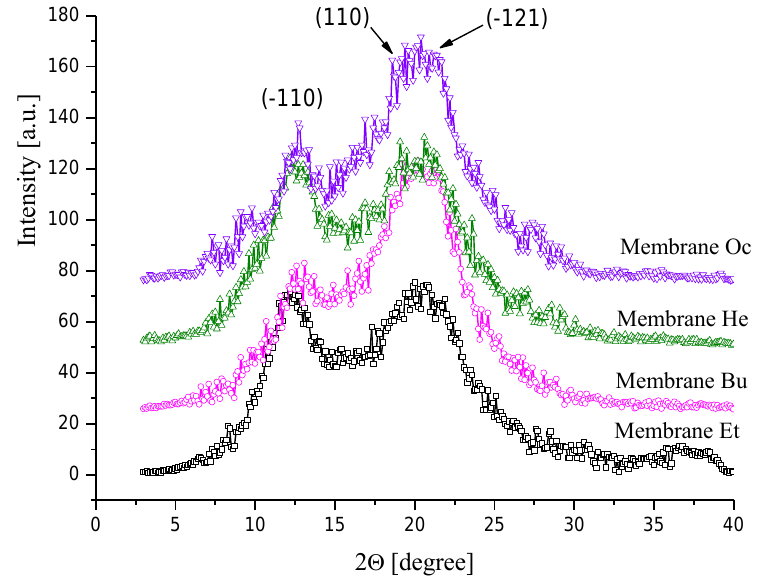
Figure 8. Examples of wide-angle X-ray (WAXS) patterns of CEL membranes.